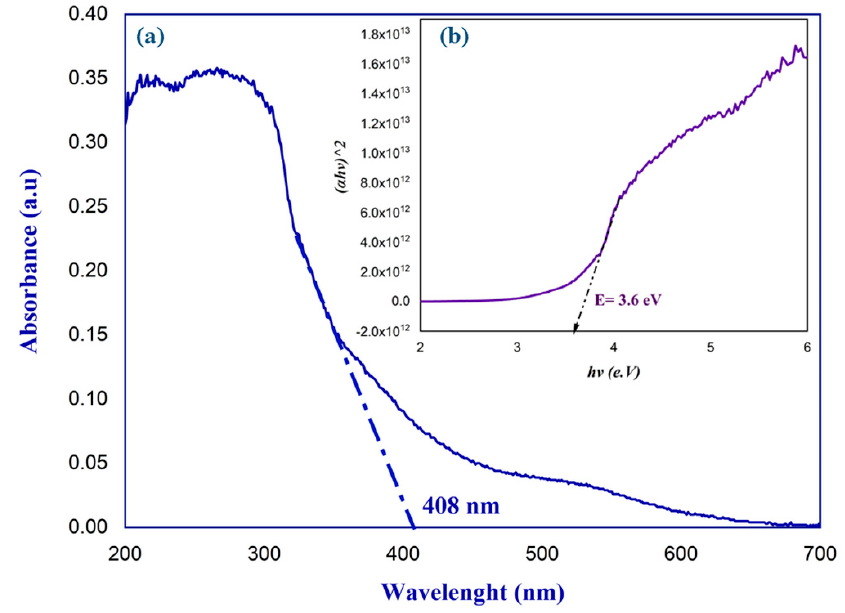
Figure 8. Solid-state UV-visible absorption spectra ( a ) and the Kubelka-Munk transformation of absorption data ( b ) of (H2Fluconazole).SnCl 6 .2H 2 O.